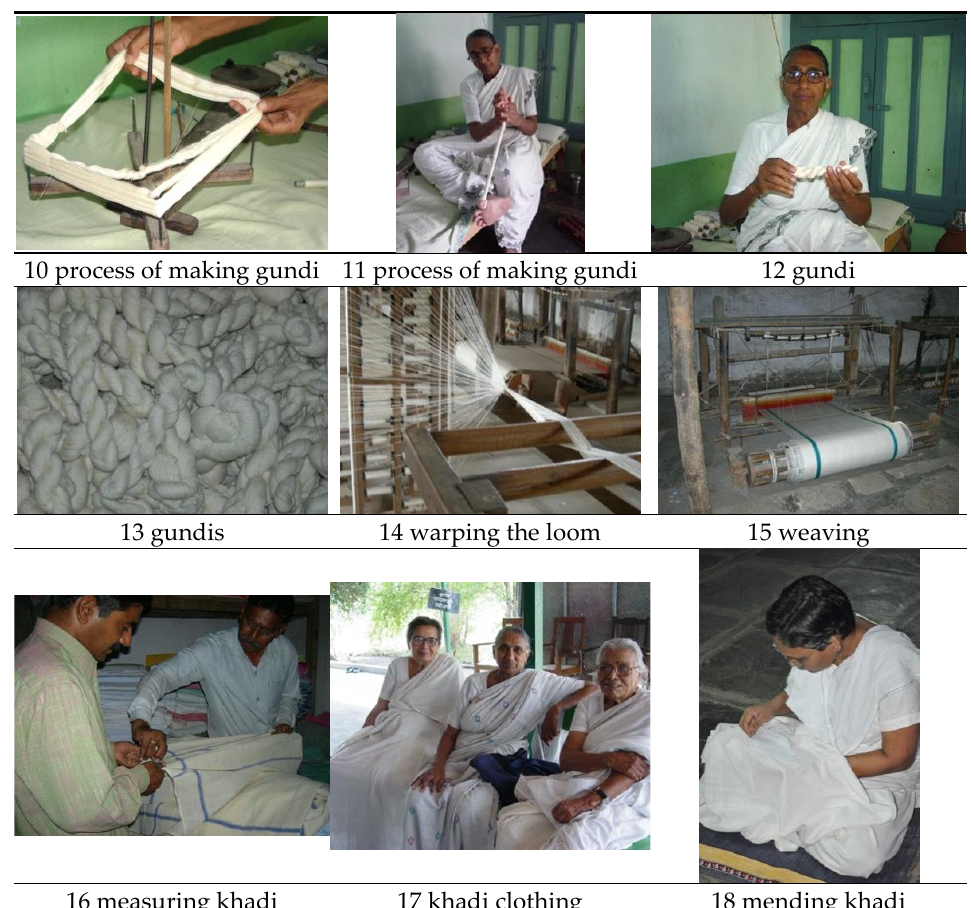
Figure 1. Process of making khadi at the Brahma Vidya Mandir.